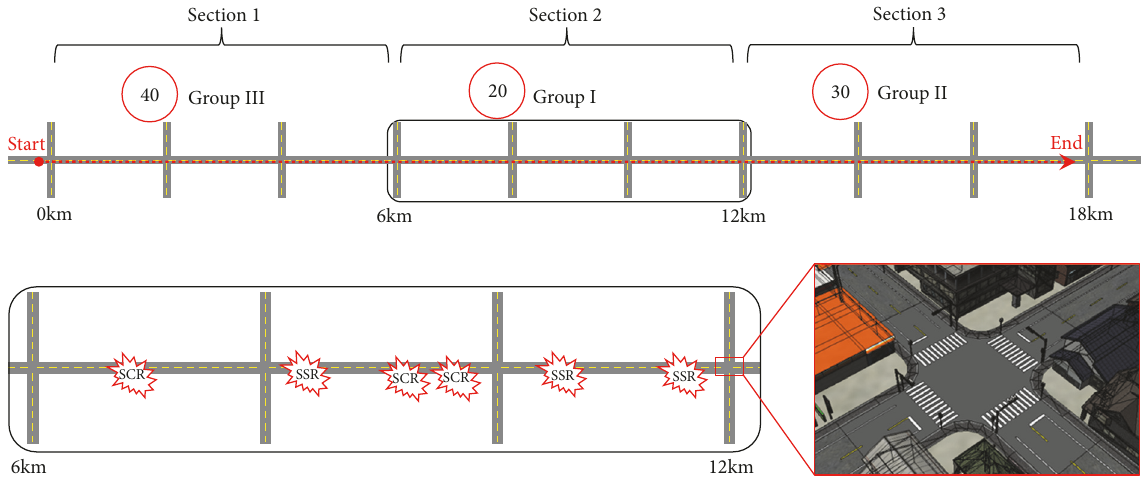
Figure 3: Allocation of the conflicts in simulation.